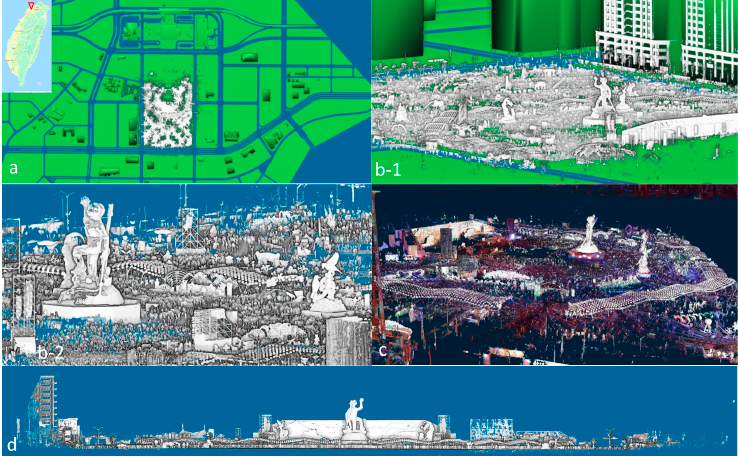
Figure 8. ( a ) Reconstructed festival scene and existing urban model, ( b-1 ) perspectives of the point-cloud model in plain mode, ( b-2 ) a closer view of the model details, ( c ) perspective of the point cloud in original color, and ( d ) elevation with the presentation of crowds at ground level.